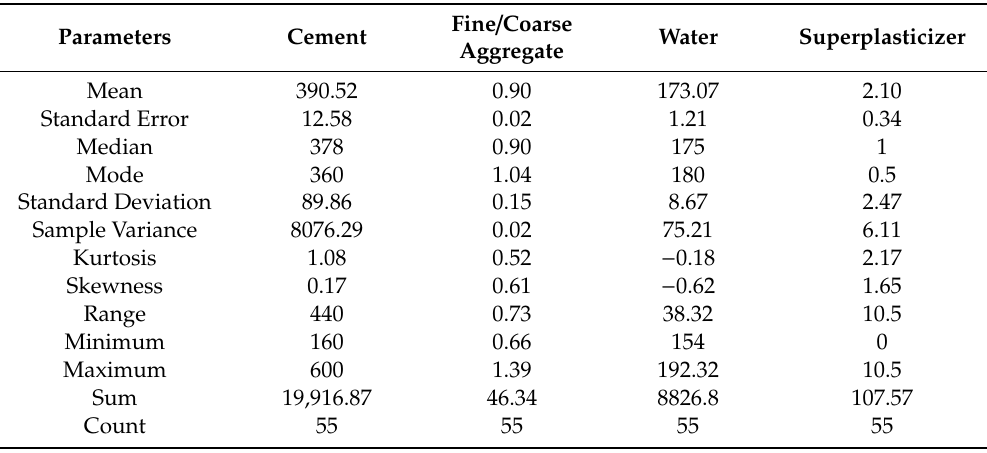
Table 5. Statistical description of validate data points used in the model (Kg / m 3